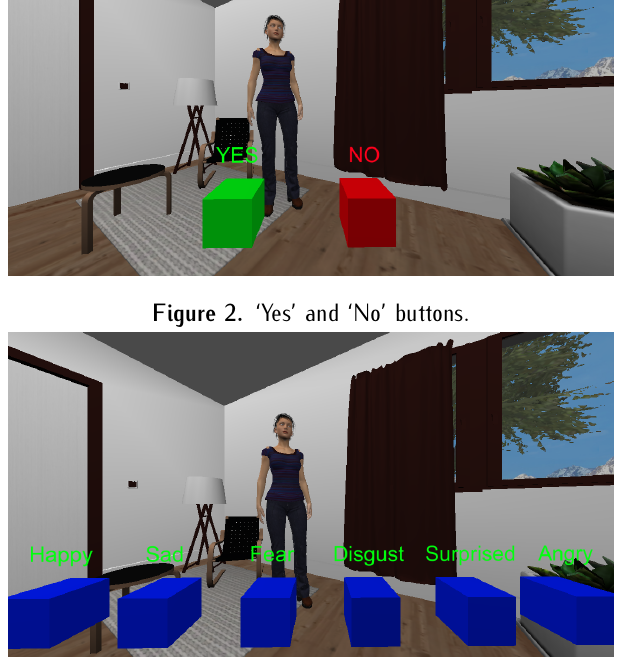
Figure 3. Emotion